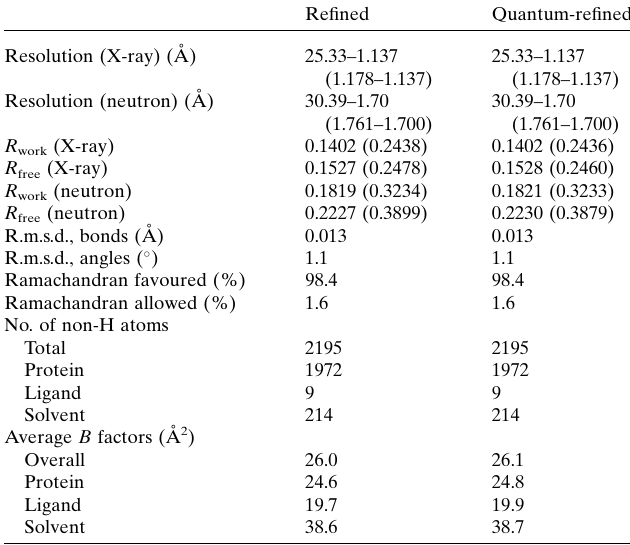
Table 1 Refinement statistics of the refined (PDB entry 7az3) and quantum- refined (PDB entry 7az4) structures of PGA–TIM.